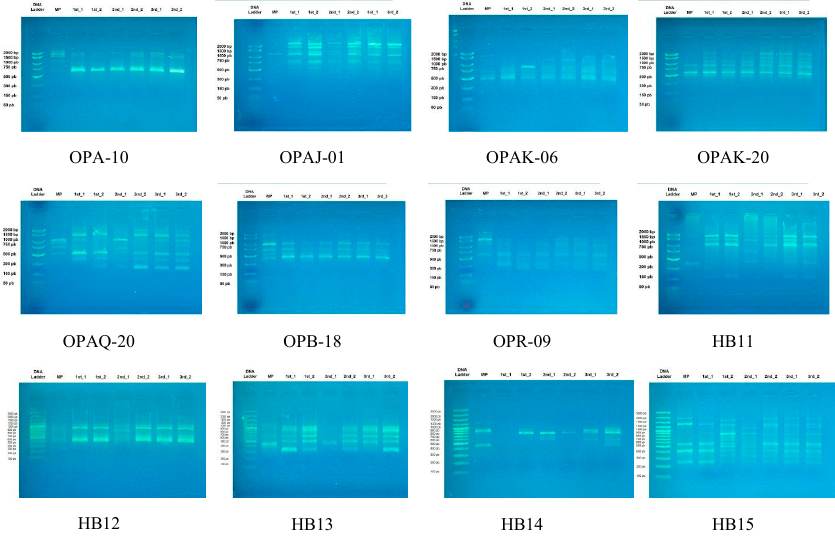
Figure 3. RAPD and ISSR profiles with primers mentioned in Table 1 of three micropropagated generations of L. schweinfurthii compared to the mother plant. MP, mother plant; 1st, first-generation plantlets; 2nd, second-generation plantlets; 3rd, third-generation plantlets.